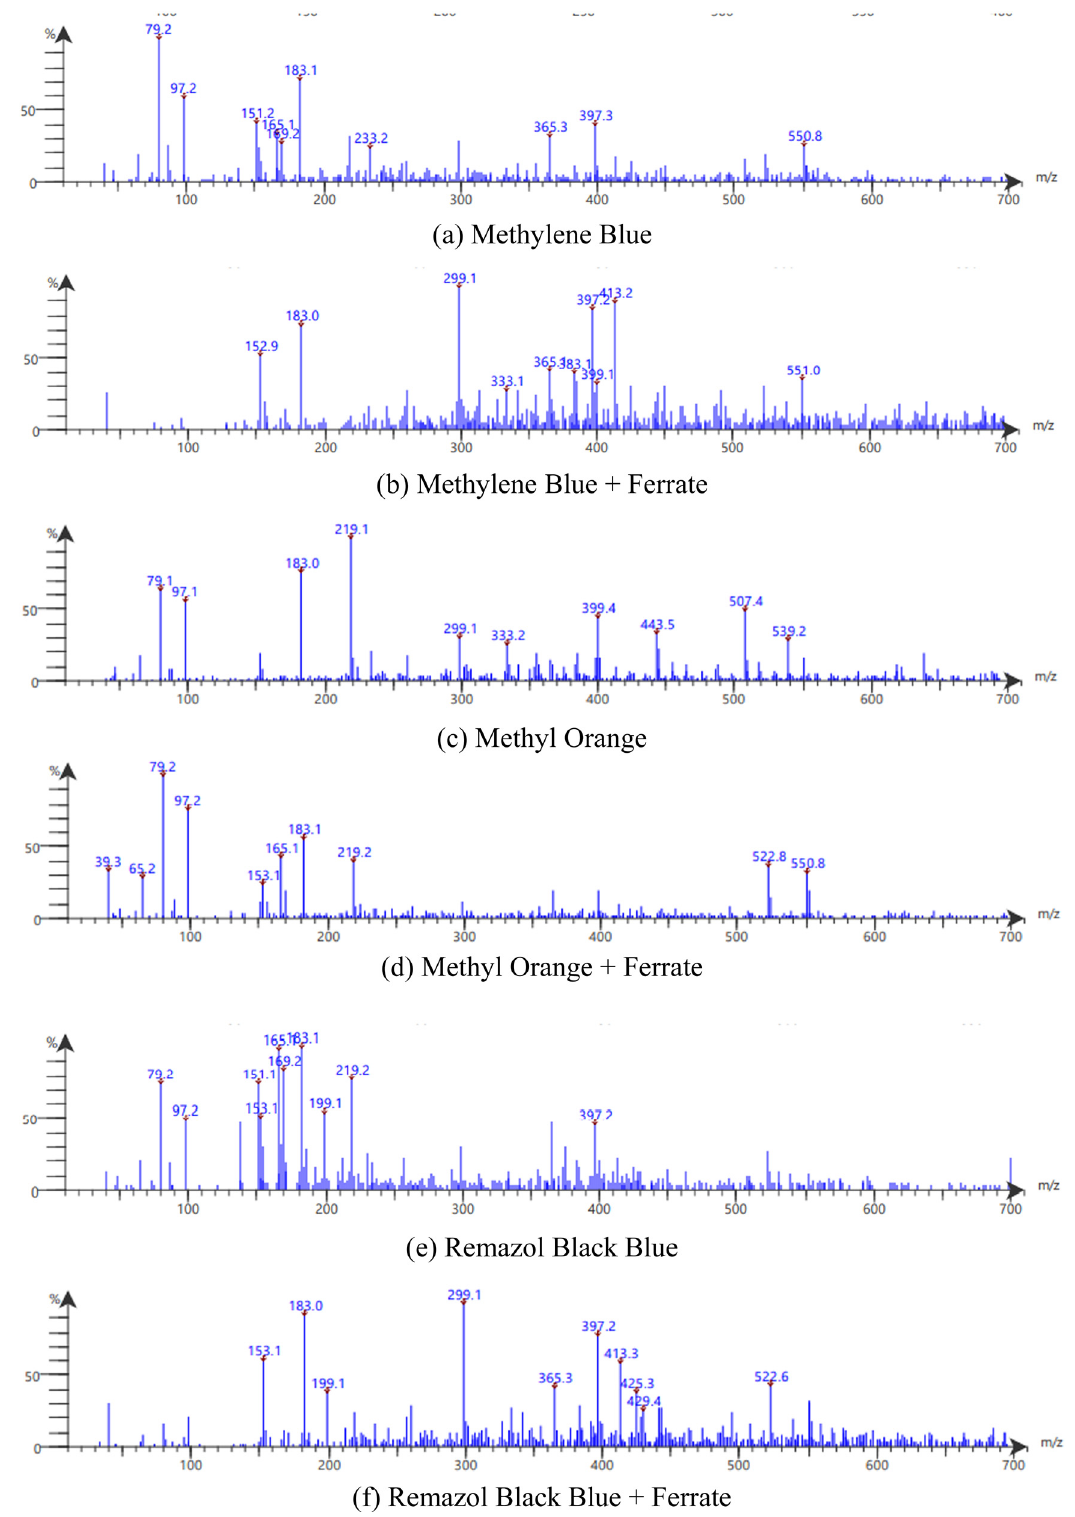
Figure 10: LC/MS spectra of MB ( a ) & ( b ) , MO ( c ) & ( d ) , and RBB ( e ) & ( f ) before and after treated with